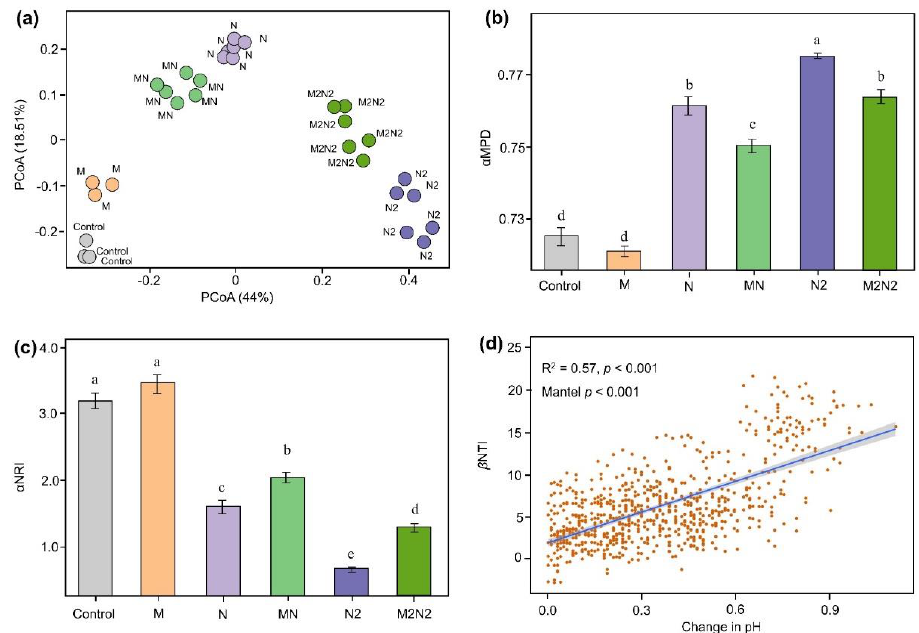
Figure 2. Phylogenetic signals under different fertilizations. ( a ) Principal co-ordinates analysis plot basing on Bray–Curtis distance; ( b ) Mean pairwise phylogenetic distance of α diversity ( α MPD); ( c ) Nearest relative index of α diversity ( α NRI); ( d ) correlation analysis between β NTI and changes in pH. Bars with different letters (shown in above) are significantly different ( p < 0.05).